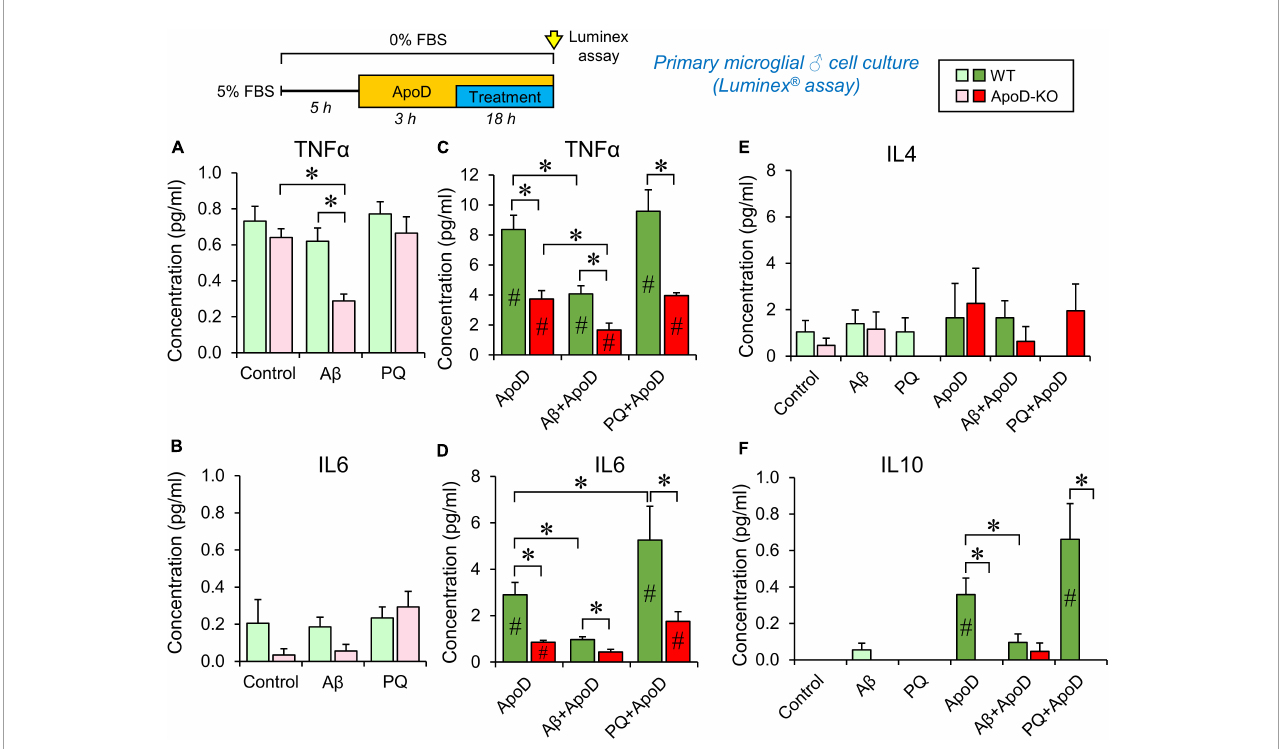
FIGURE4 Cytokine secretion profiles of male primary microglia in control conditions, PQ-induced OS or exposure to A β -oligomers. Luminex multiplex assay is used on primary microglia culture media after 18 h incubation under different conditions (control, 1 µ M A β oligomers, or 25 µ M PQ). Concentration of each cytokine secreted by WT microglia (shades of green color), and ApoD-KO microglia (shades of red colors) are represented. Light colors (light green or pink) represent values obtained without exposure to ApoD, and dark colors (dark green or red) represent values obtained when stimuli were preceded by the addition of purified human ApoD (50 nM) to the culture medium. ApoD is maintained during the treatment period. Each profile represents 2–3 technical replicas of conditioned media produced by two independent primary cultures/genotype/sex. Bars represent average ± SEM. Asterisks point to significant differences among groups within each graph, and # point to differences between conditions, with or without ApoD acute exposure, evaluated by ANOVA followed by Holm-Sidak pairwise